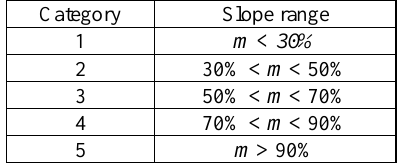
Table 3. Slope ranges adopted for the assessment of the DSM accuracy vs